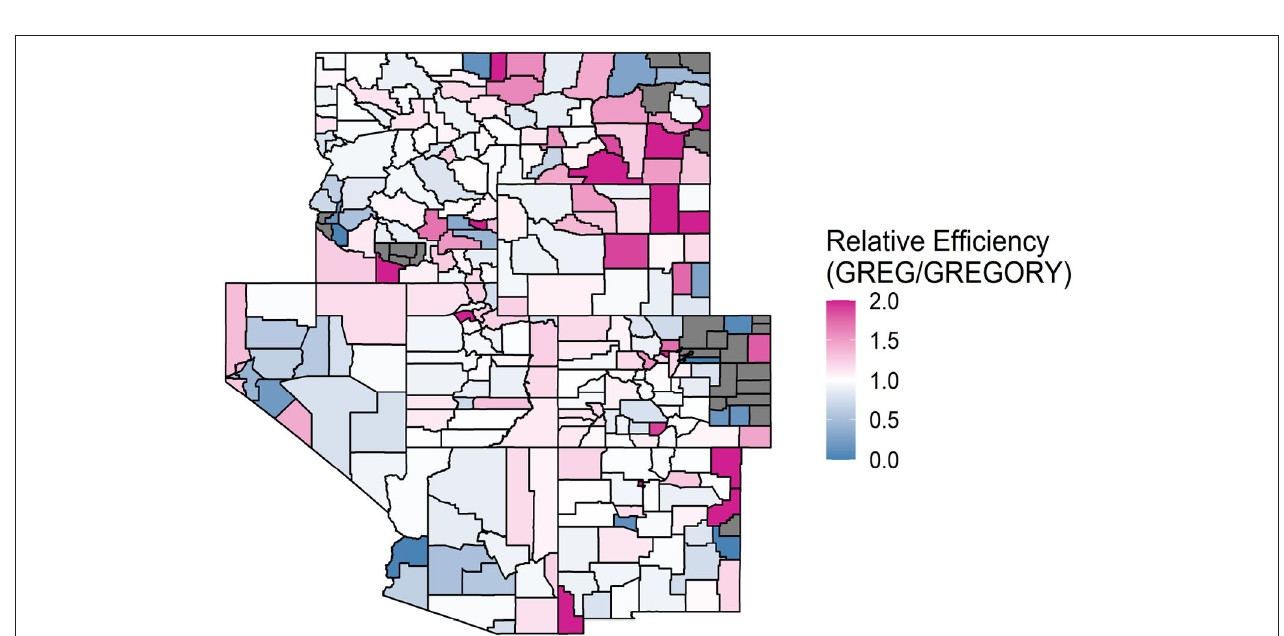
FIGURE 3 | A map of the relative efficiencies of the GREG to the GREGORY when estimating the average trees per acre for each county in the Interior West. Values above 1 indicate that the GREGORY is more efficient. Values greater than 2 were truncated to 2 to increase the readability of the map. A county is gray if the RE is 0, due to all plots containing values of 0 trees per